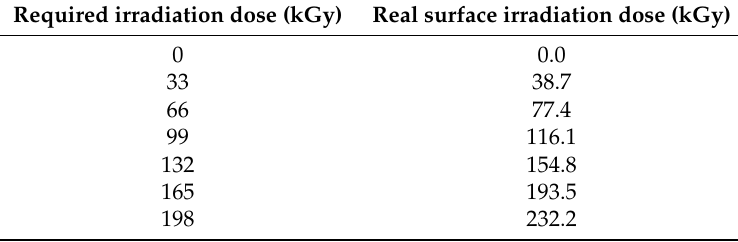
Figure 1. Dimensions of testing specimen. Table 3. Irradiation dose of